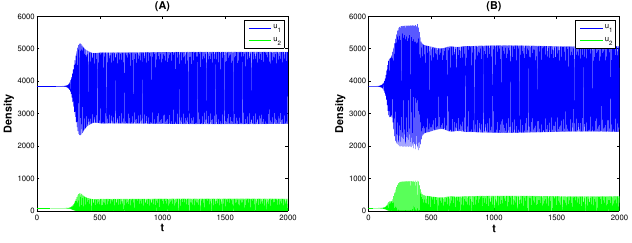
Figure 3. Dynamical behavior of the spatio-temporal model in local place. The left figure corresponds to the one spiral wave pattern. The right figure corresponds to the two spiral wave